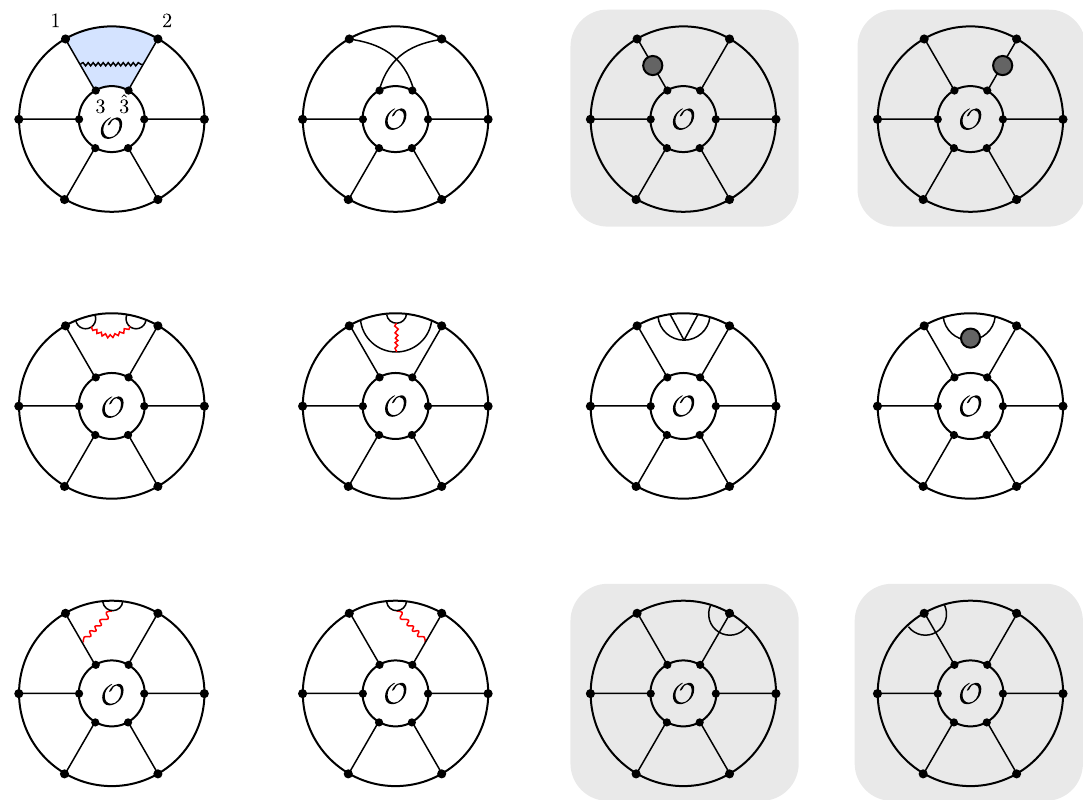
Figure 44 . One-loop corrections to the three-point function. Here we depicted corrections associ- ated with the face colored in blue in the (cid:12)rst diagram. The diagrams drawn on a gray background come with a factor of 1 =